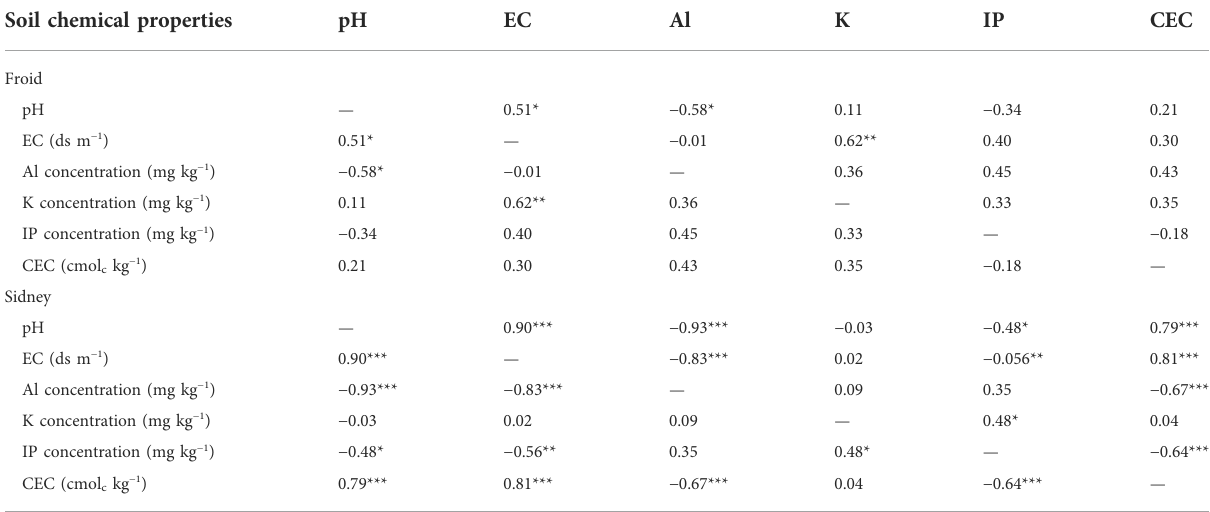
TABLE 2 Correlation (r) among soil pH, electrical conductivity (EC), cation exchange capacity (CEC), and Al, K, and inorganic P (IP) concentrations at Froid ( n = 16) and Sidney ( n = 24), Montana, United States. Soil chemical